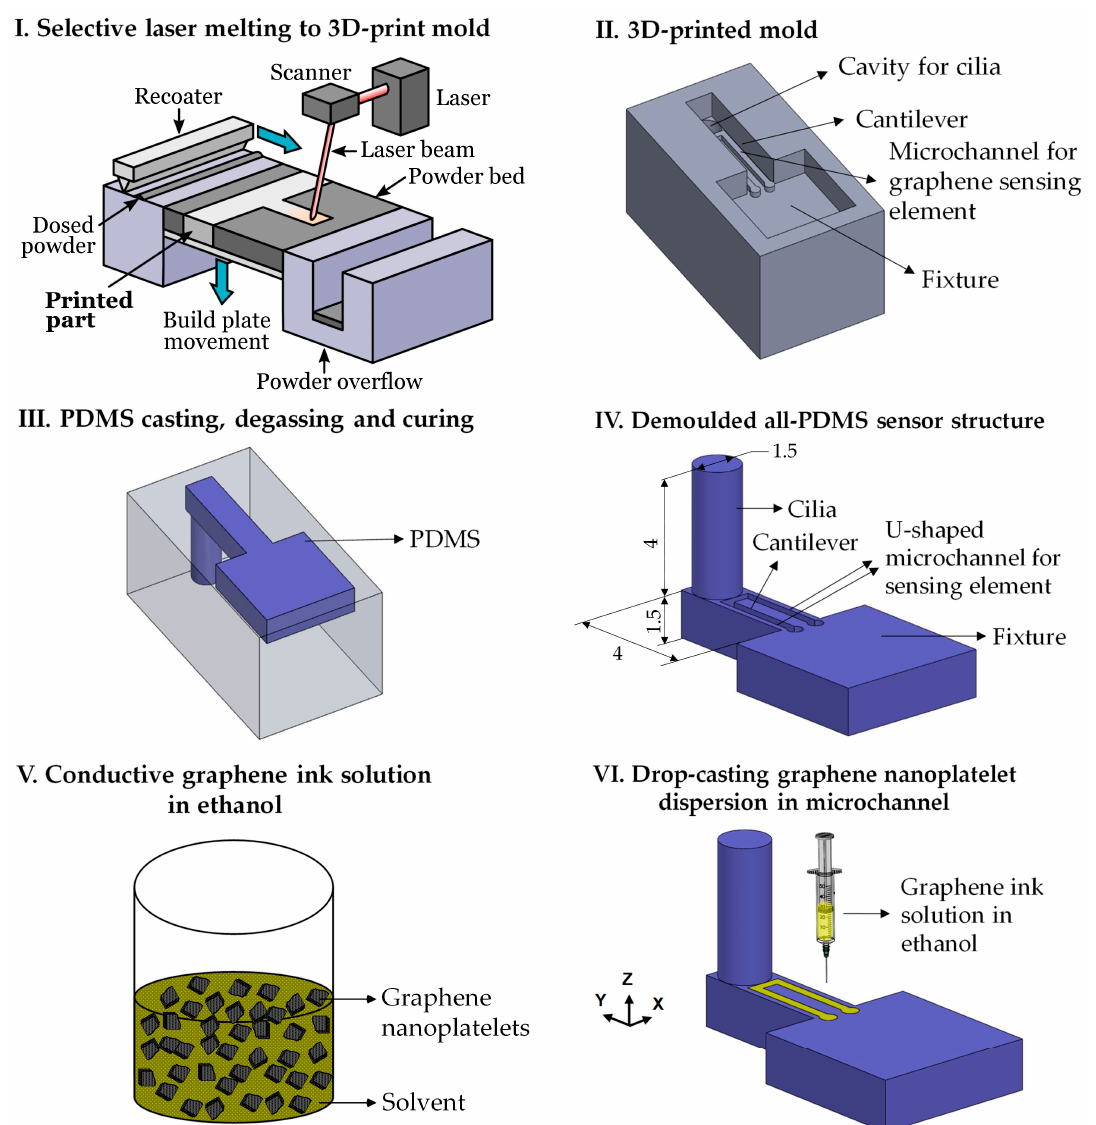
Figure 2. Schematic of fabrication process flow involving metal 3D printing (selective laser melting), PDMS casting, and graphene infusion into microchannel. Selective laser melting (SLM) process schematic (Image I) reprinted with permission from [54], Copyright Elsevier, 2019. All dimensions in Image IV are in mm. The size of the graphene nanoplatelets in Image V is exaggerated.